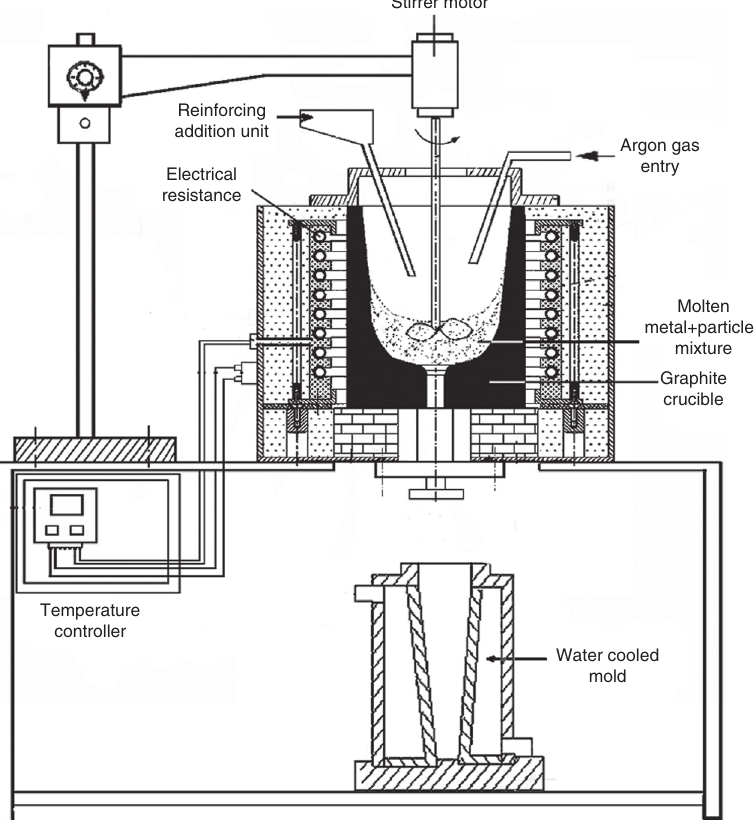
Cp composites 4